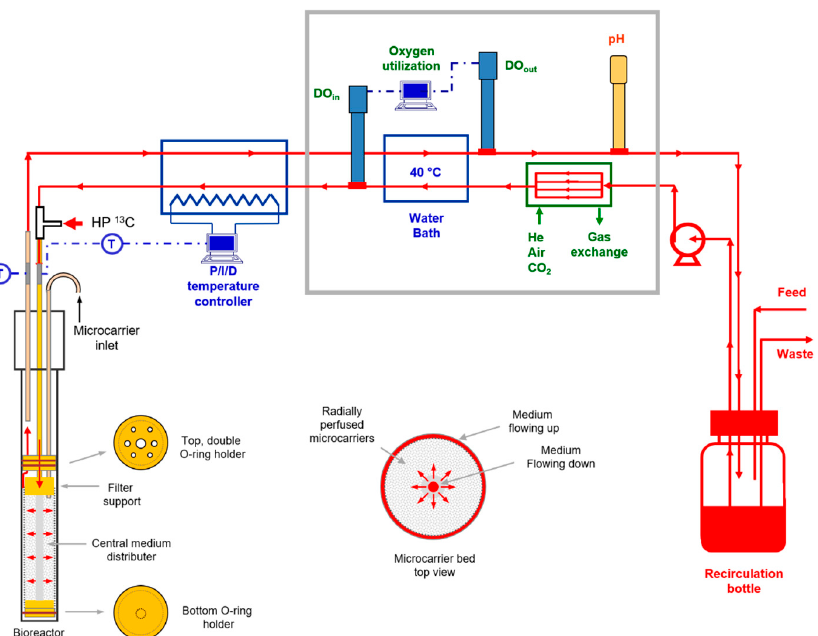
Figure 9. Radial flow perfusion system for microcarrier-immobilized cells. The perfusion system was similar to the one described previously for axial flow [25]. The medium was circulated through a continuous loop that included a peristaltic pump, a gas exchange module, two oxygen probes (one for the inlet medium and one for the outlet), a P/I/D-controlled heater, the NMR tube with microcarrier- immobilized cells, a secondary temperature probe, a computer for continuous calculation of the oxygen consumption rate, a pH probe, and a medium recirculation bottle. To prevent depletion of metabolites in the recirculating medium, a continuous feed of fresh medium was used in conjunction with continuous waste removal.